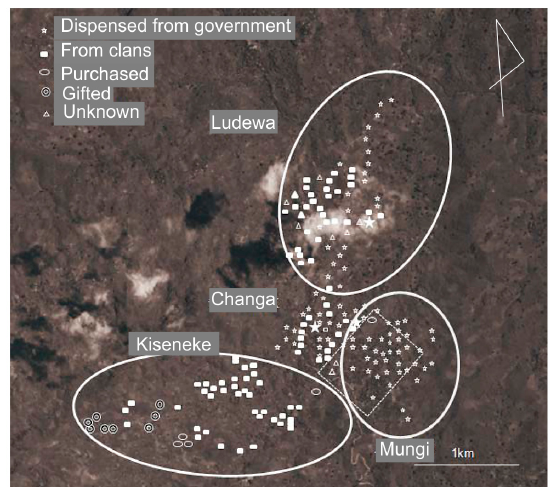
Figure 5. Distributions of 258 households in the four village districts shown using different symbols according to the methods of how the lands were obtained. The symbol ( ☆ ) indicates the households which were forced to migrate, received their homegarden plot from the village government, and continue to live on that land. Quick bird image (2005).